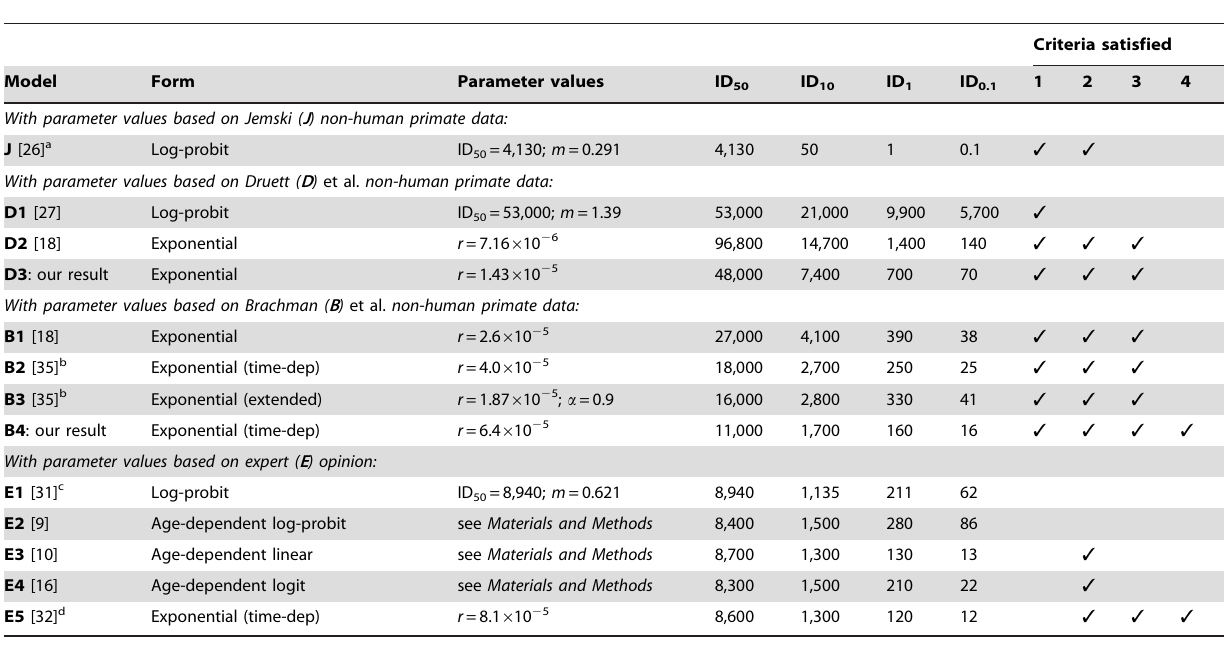
Table 1. Summary of anthrax dose-response